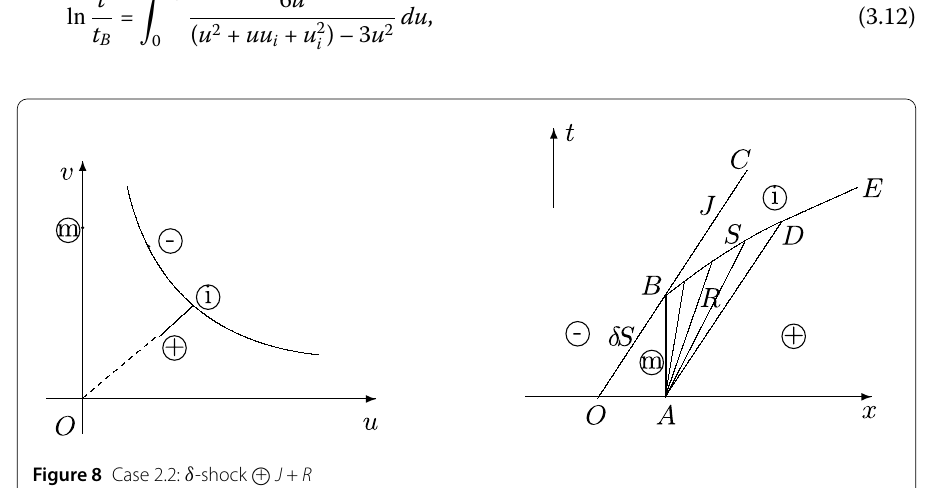
Figure 8 Case 2.2: δ -shock + (cid:10) J +